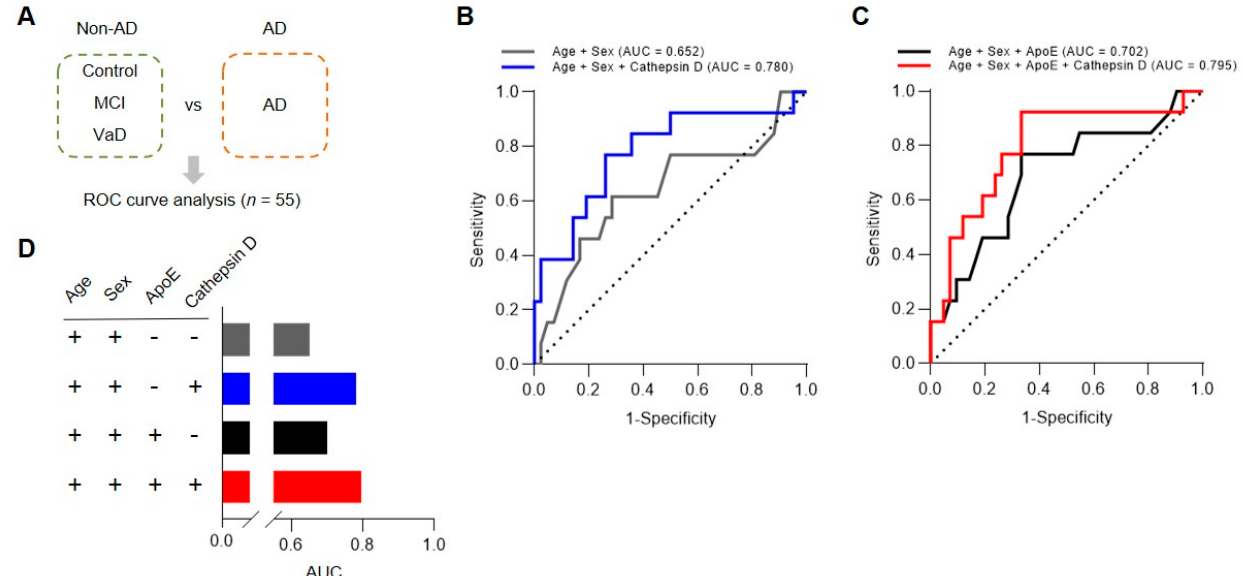
Figure 6. Analysis of plasma cathepsin D biomarker performance in distinguishing AD from non-AD subjects. ( A ) Categorized subject groups for logistic regression analysis. ( B – D ) Comparison of ROC curve among combinations of variables (age, sex, ApoE, cathepsin D). Details are described in Table 2. Table 2. Detailed information on receiver operating characteristic (ROC) curve analysis.